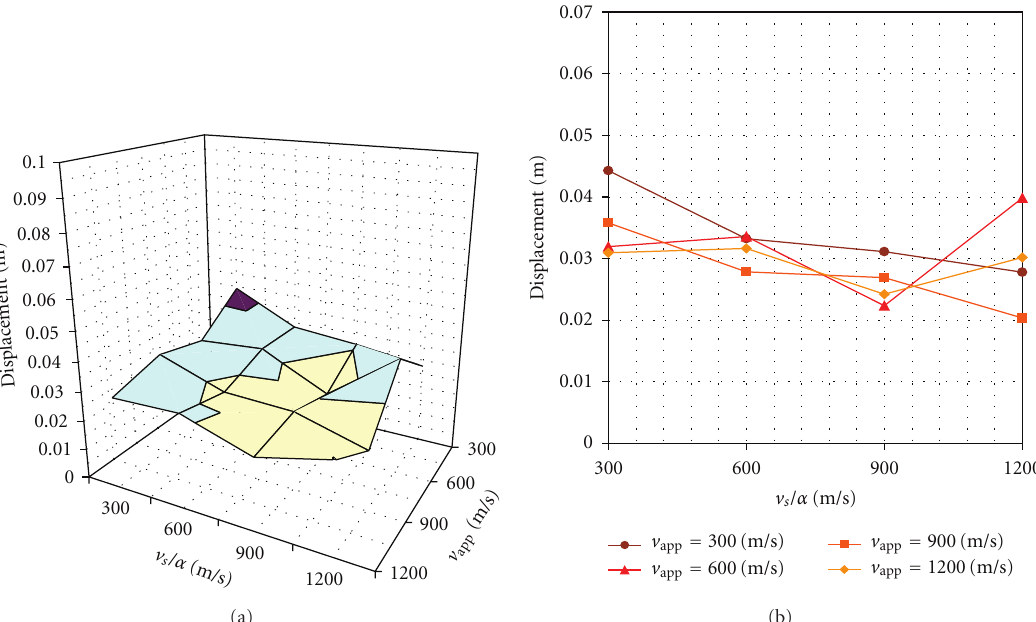
Figure 13: Pier-deck di ff erential displacement varying with seismic input correlation level (represented by parameters v s /α and v app ): (a) 3D view and (b) 2D view.